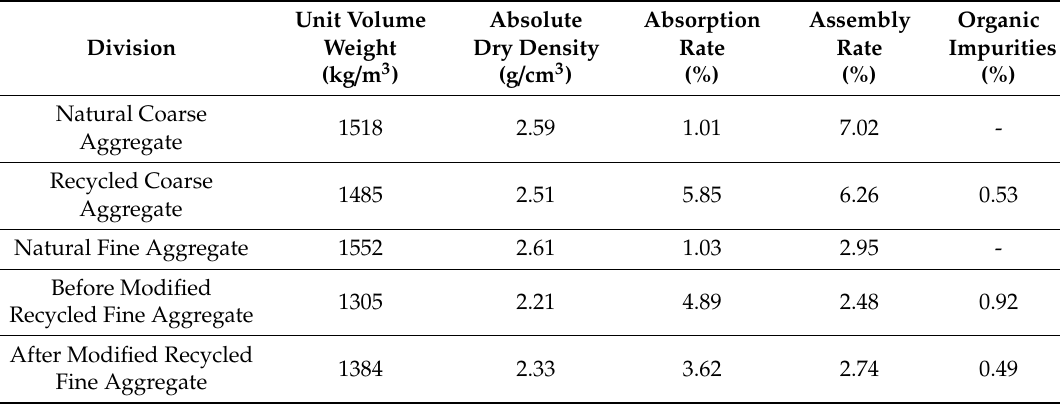
Table 1. Physical properties of natural aggregate and recycled aggregate.